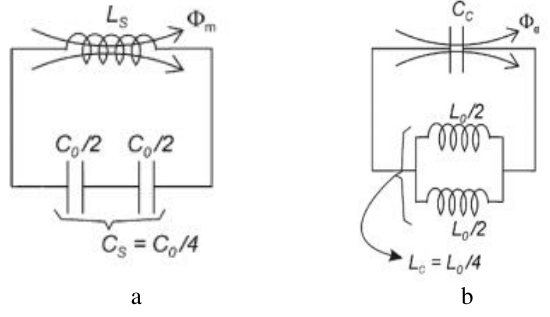
Figure 3: Equivalent circuit model of a SRR b CSRR Fractal curves are self repetitive and space filling curves